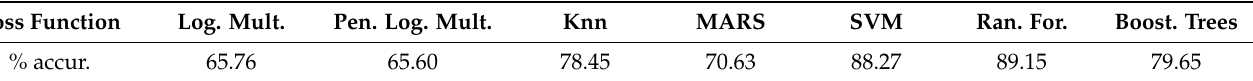
Table 4. General accuracy (% of correct classifications in test data).